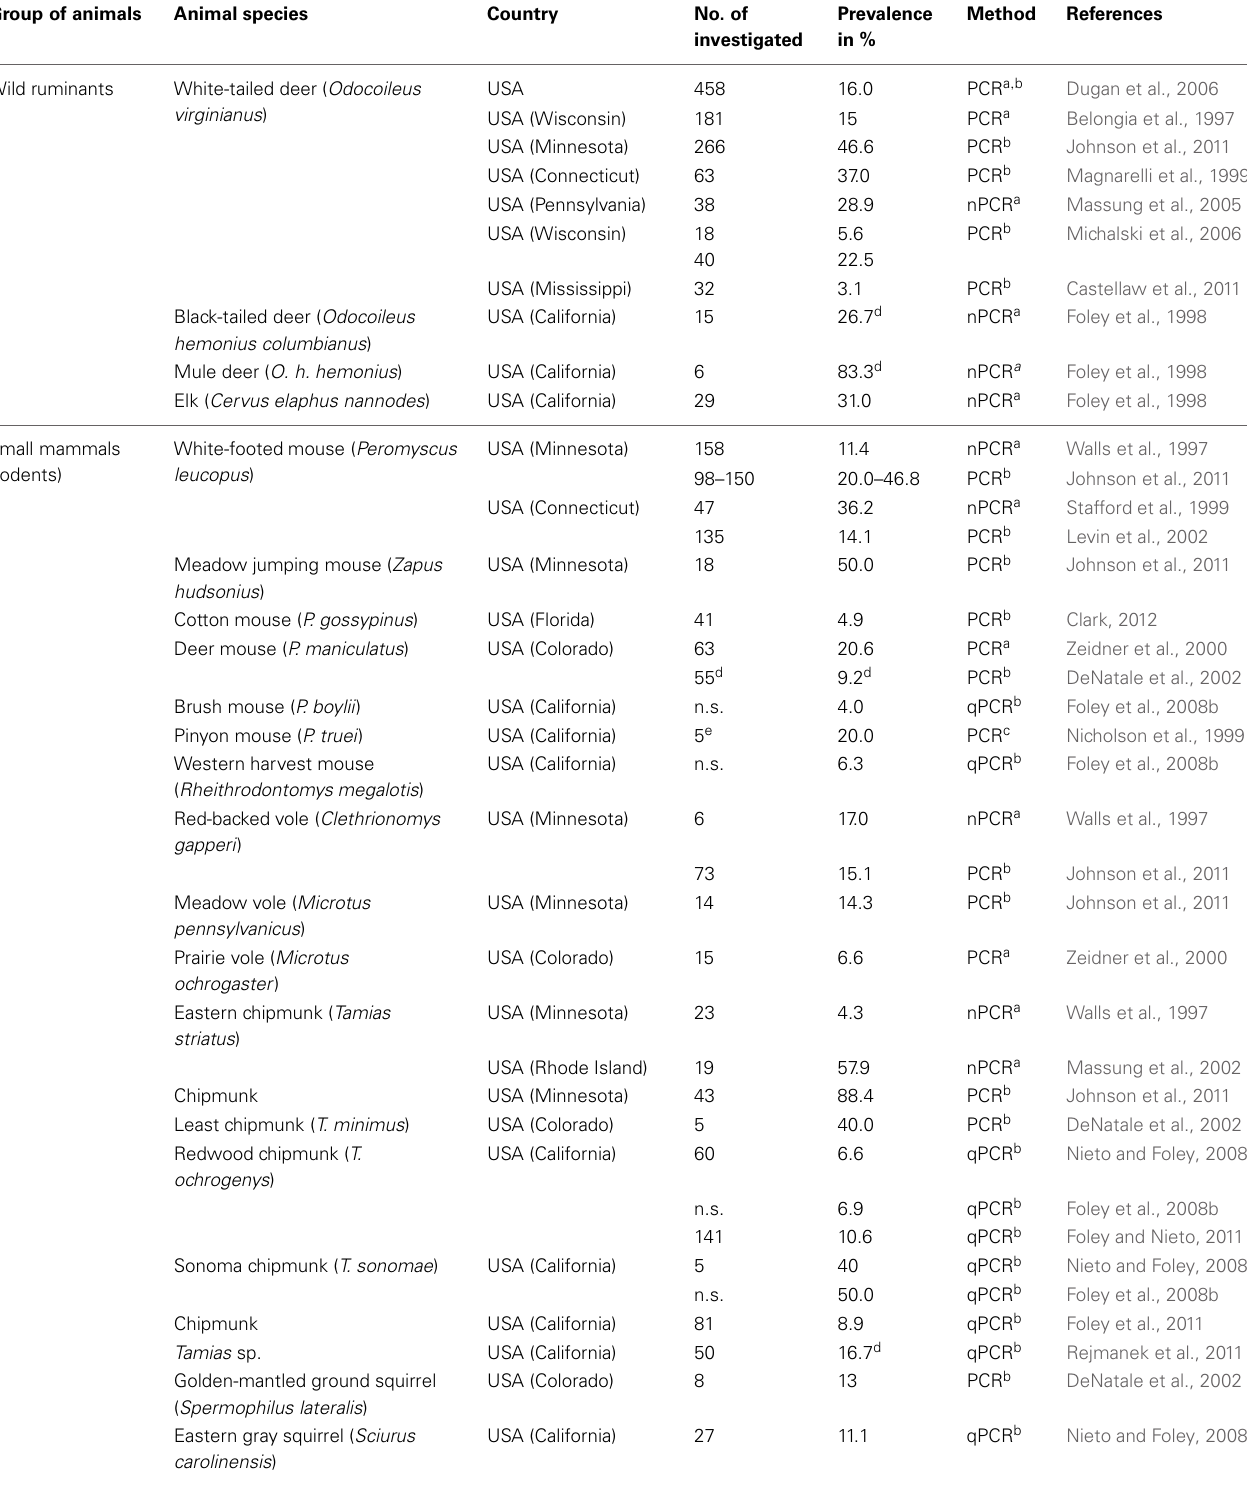
Table 6 | DNA-Detection of Anaplasma phagocytophilum in blood/spleen in vertebrate hosts in the Americas*. Group of